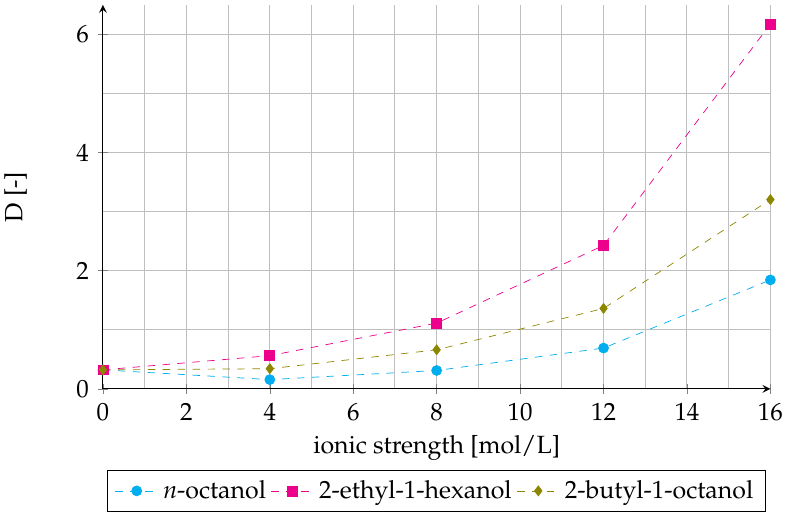
Figure 7. Effect of ionic strength on the distribution ratio by the extraction of boric acid by 2-ethyl-1- hexanol, 2-octanol and 2-butyl-1-octanol dissolved in kerosene (experiment (2) , Table 1).